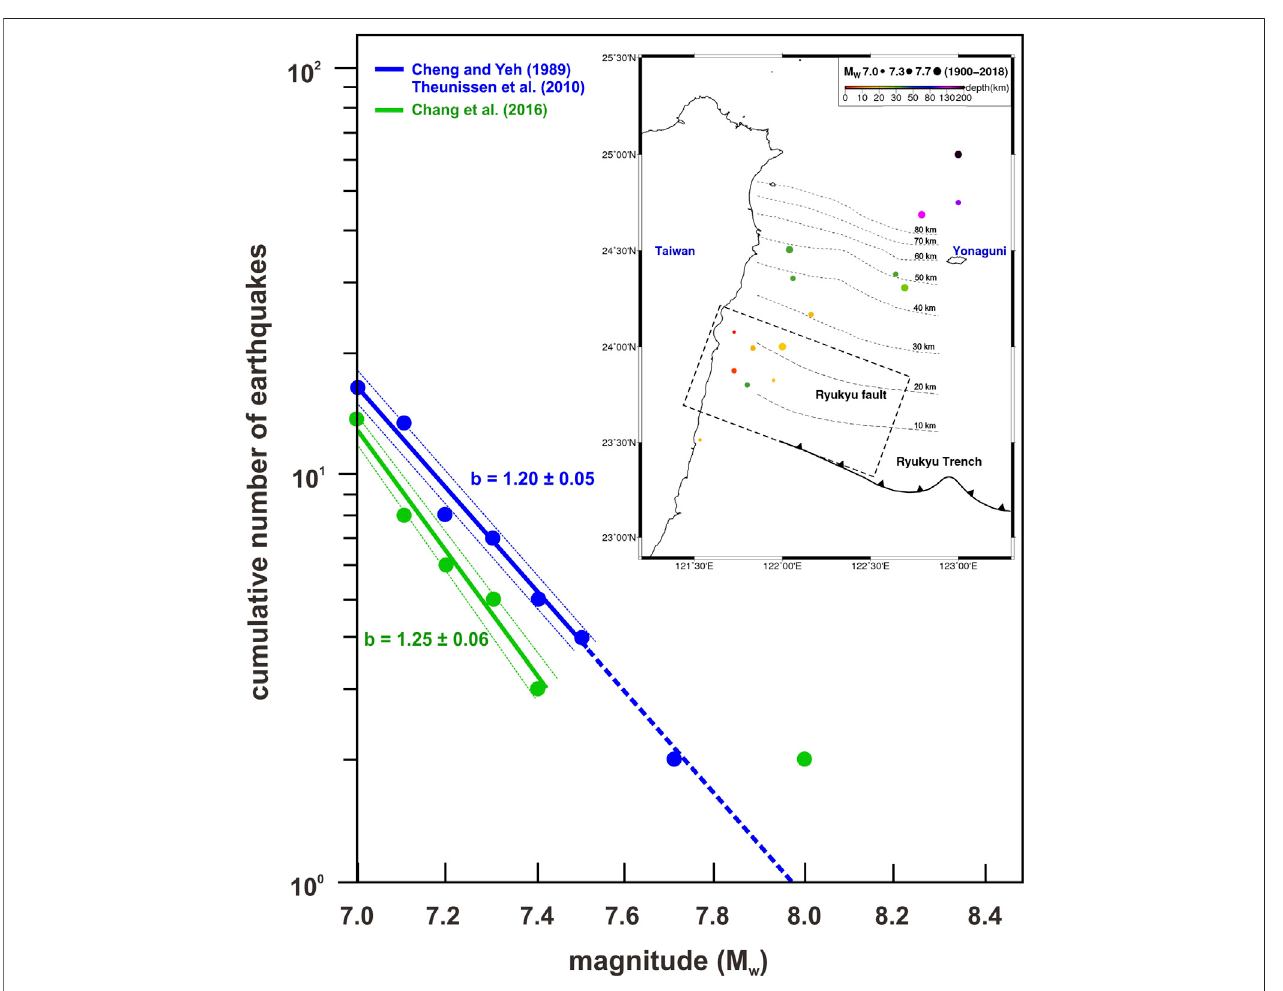
FIGURE 5 | Earthquake magnitude-frequency relation ( b value) in the southernmost Ryukyu subduction zone based on two historical earthquake catalogs in the last120 yearswithmagnitudesgreaterthanM w 7.0.Thecirclesrepresentthecumulativenumberofearthquakes( y -axis)equalto/overtheearthquakemagnitudeonthe x -axis. The solid and dotted lines represent the regression lines and uncertainties of the b value, respectively. The extended dotted line from M w 7.5 to 8.0 is assumed. The inset shows the earthquake hypocenters from Cheng and Yeh (1989) and Theunissen et al. (2010).